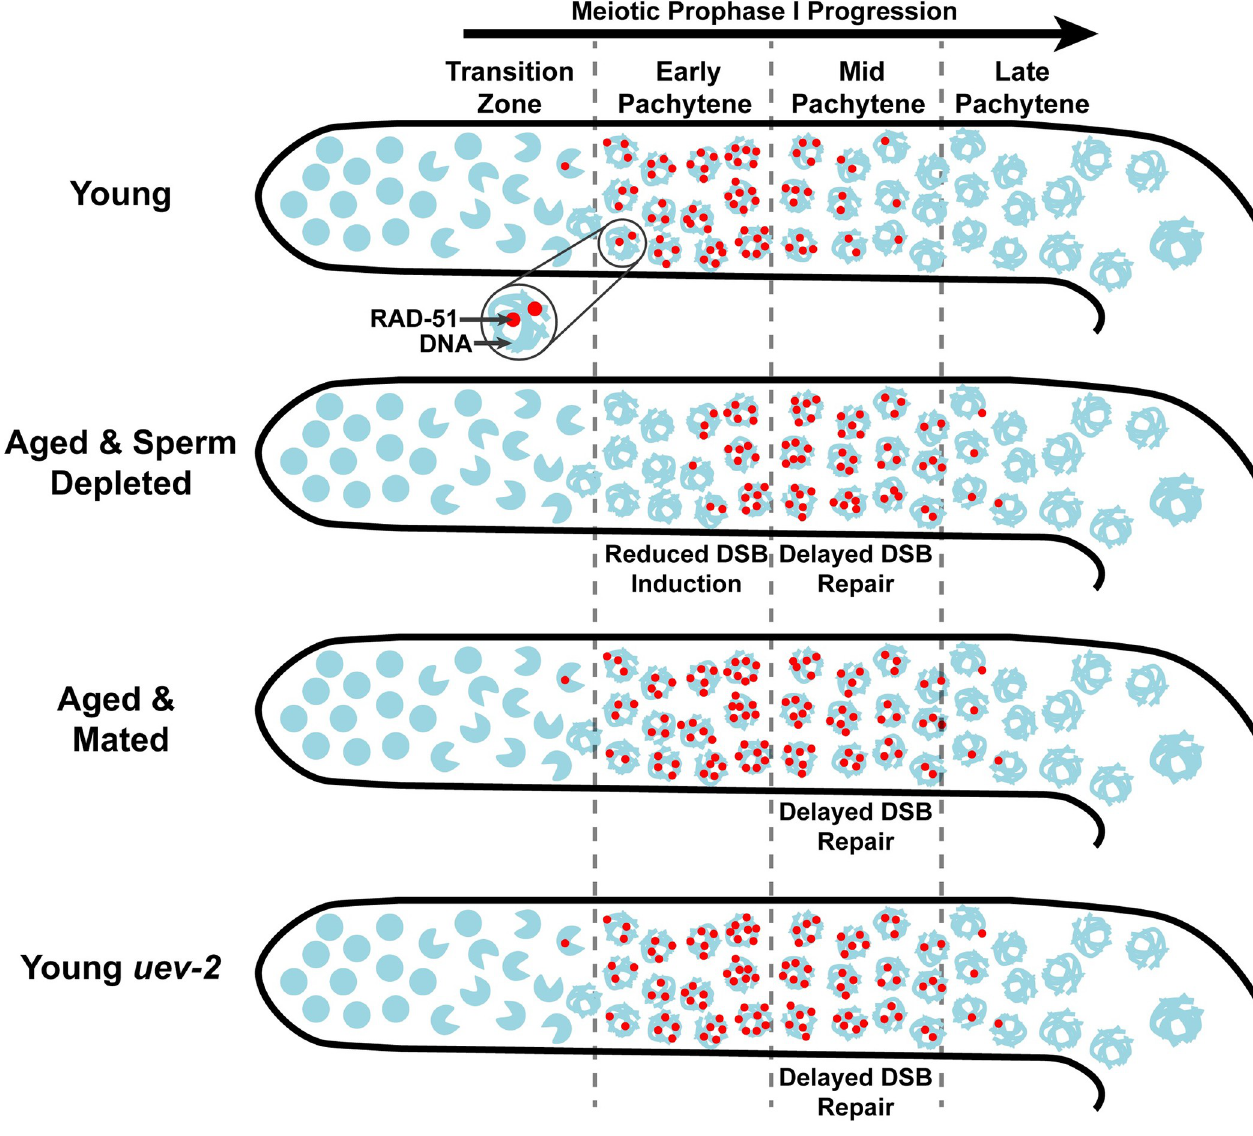
Fig 7. Model of aging and sperm effects on DSB levels during germline